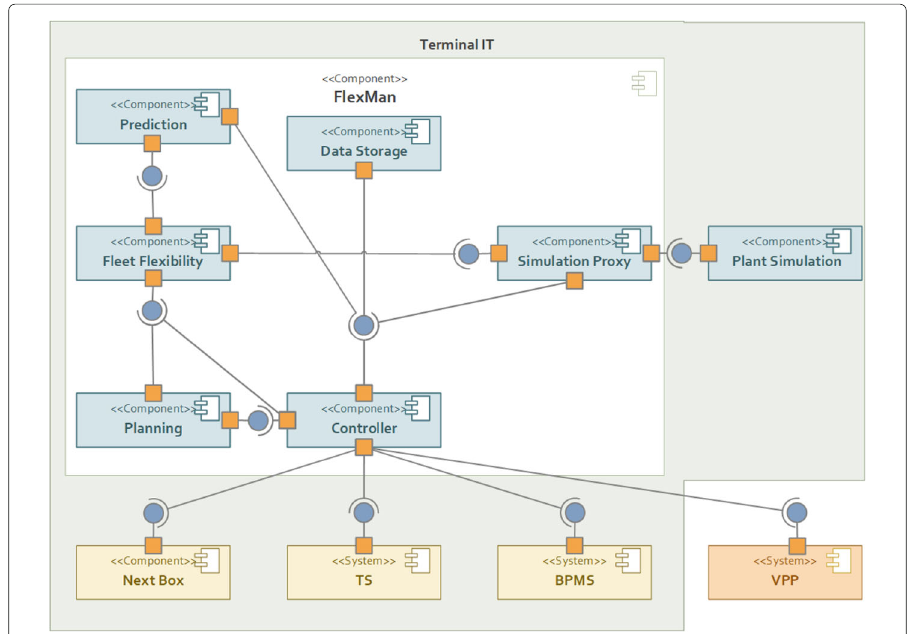
Fig. 6 Components of the FlexMan System Architecture: Core components of FlexMan are depicted inside the whitebox. Components such as Next Box , TS , BPMS and VPP are external components, that are connected to FlexMan via the Controller component. The component Simulation consists of - Simulation Proxy and Plant